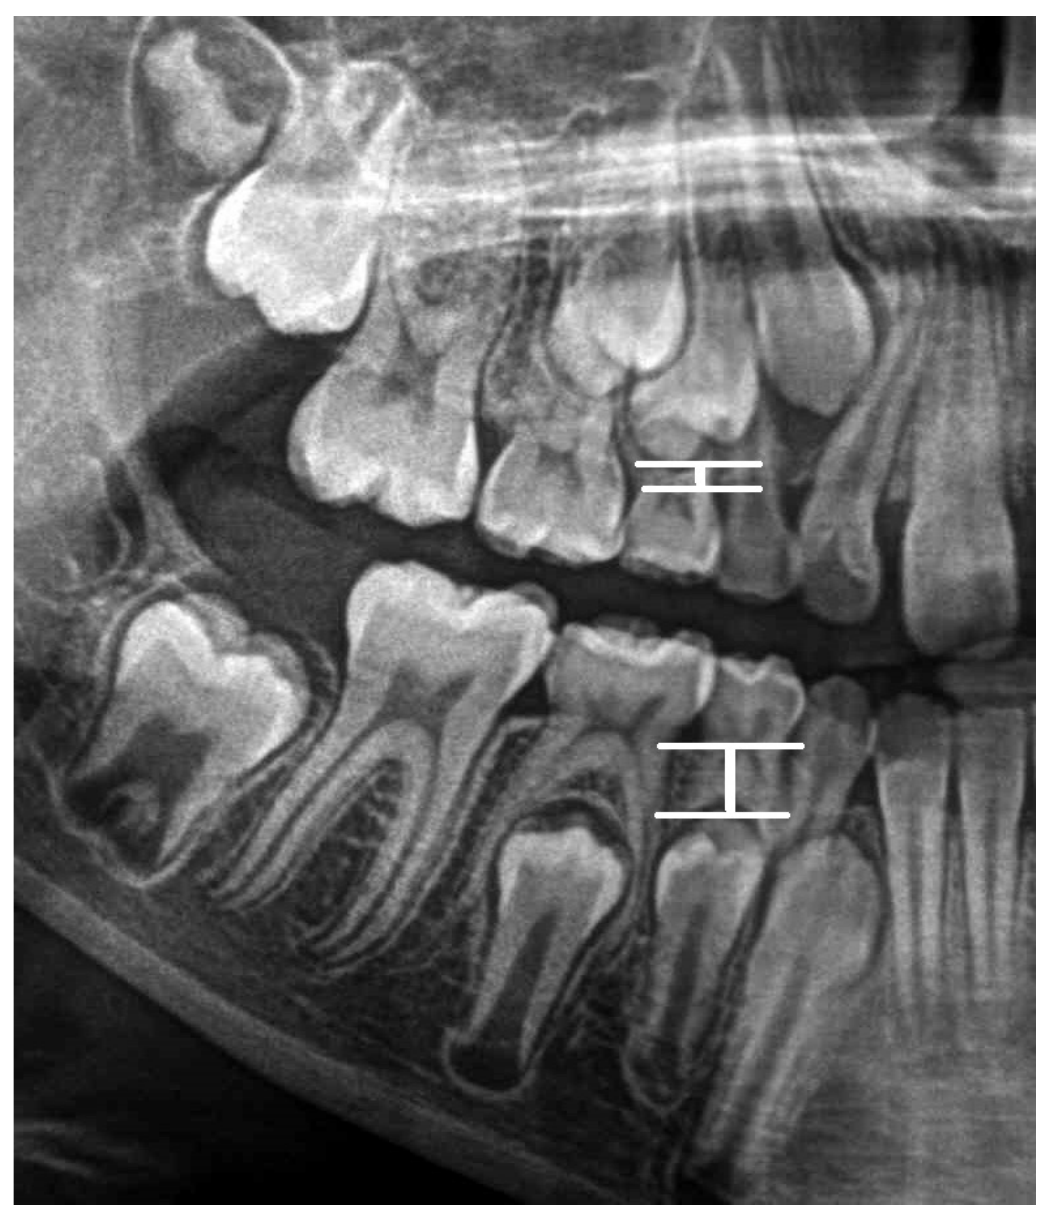
Figure 5. Graphic representation of the S14-W14 and S 44-W44 distances. S15-W15 is the distance between point S15 (on the incisal margin of tooth 15) from point W15 (the point on the alveolar margin in the line drawn through the point on top of the alveolus perpendicular to the X line).